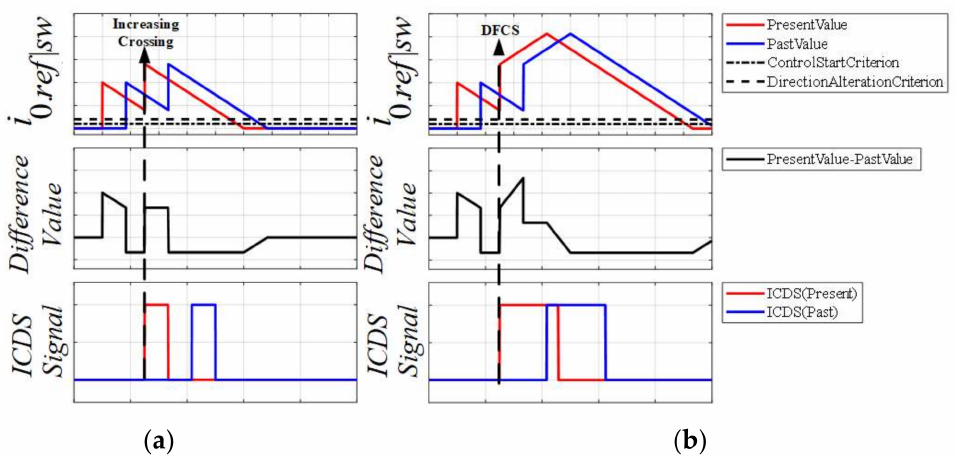
Figure 6. The conceptual trends of ZSCC’s present value, past value, and the difference between these values in case that the disturbance occurred during phase compensation ( a ) when compensating with the correct direction, ( b ) when compensating with the incorrect direction.